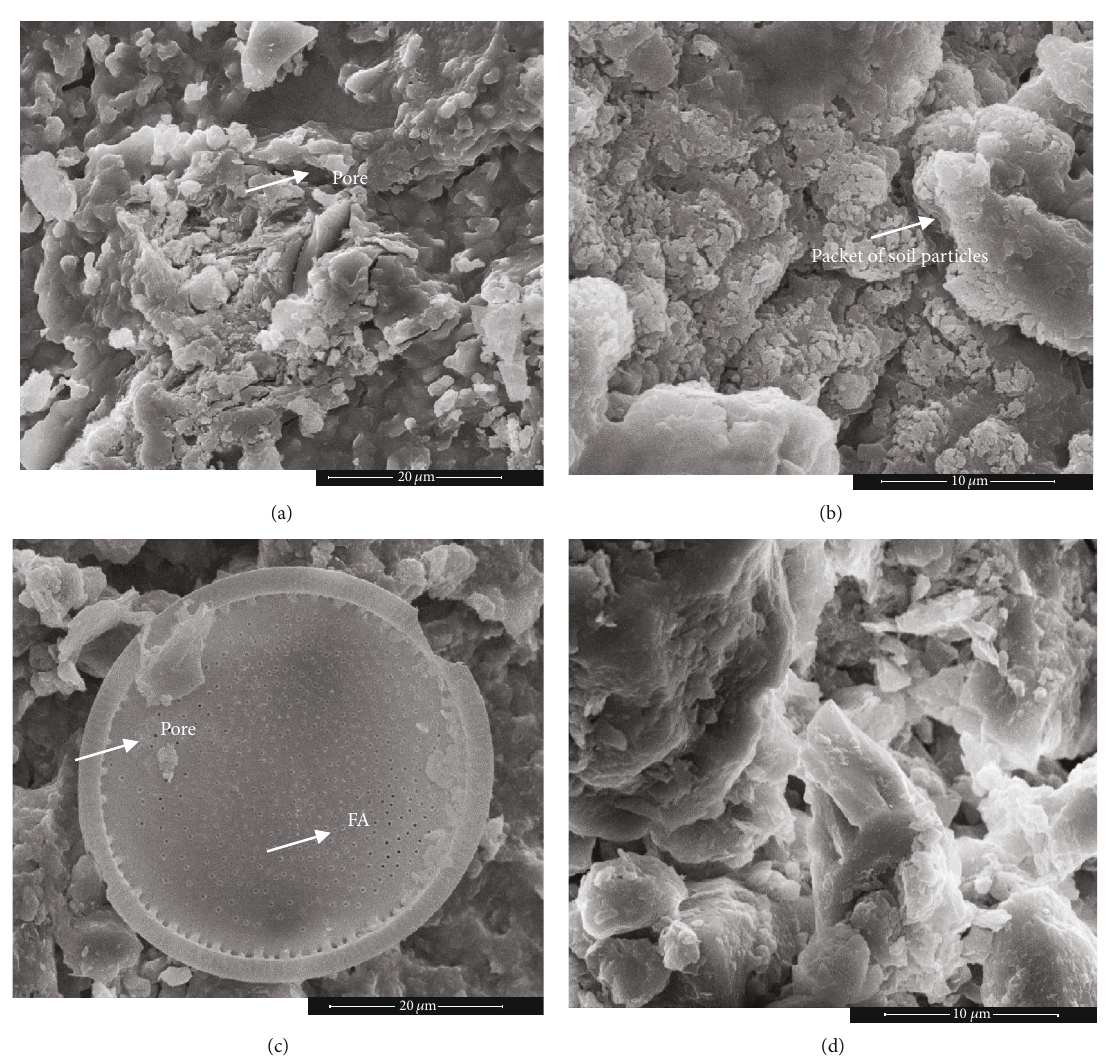
Figure 9: SEM photographs of treated soil containing varying percentages of fl y ash and cement